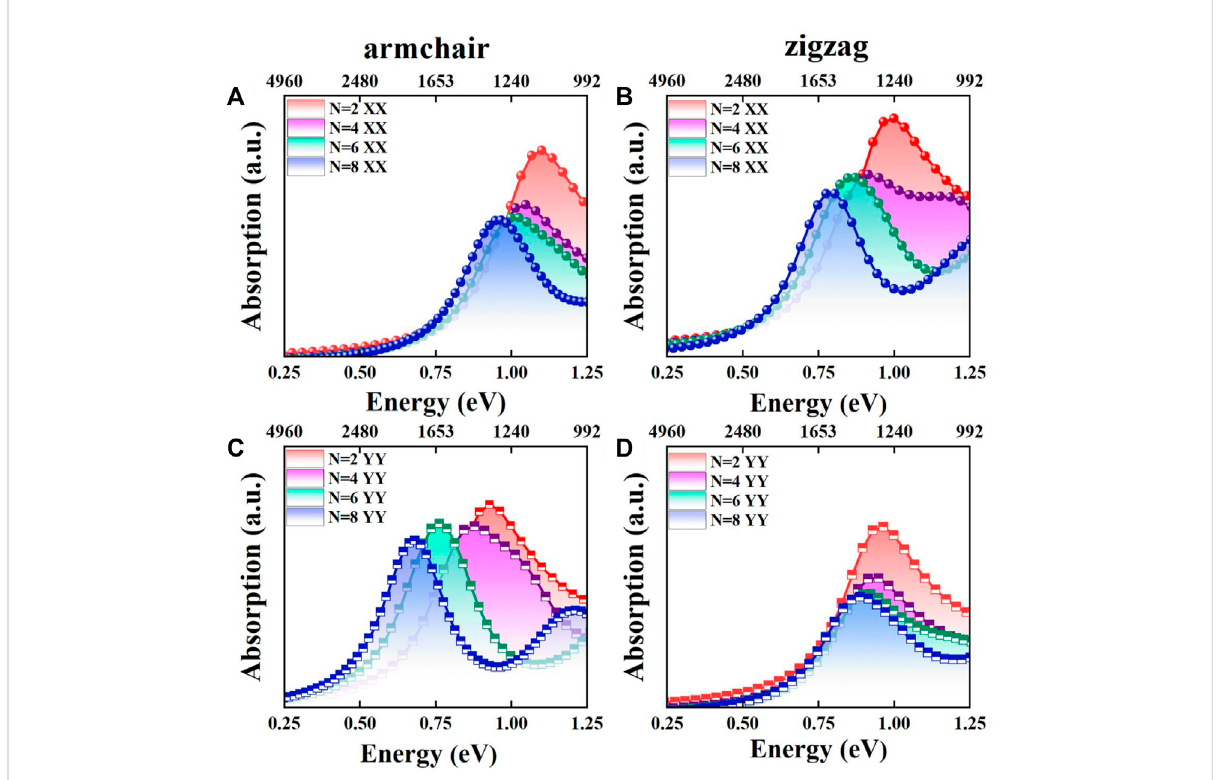
FIGURE 2 (A,C) Absorption spectra of the armchair Sb n /Bi n LHSs in XX and YY directions under n from 2 to 8, respectively; zigzag Sb n /Bi n LHSs in XX and YY directions under n from 2 to 8,